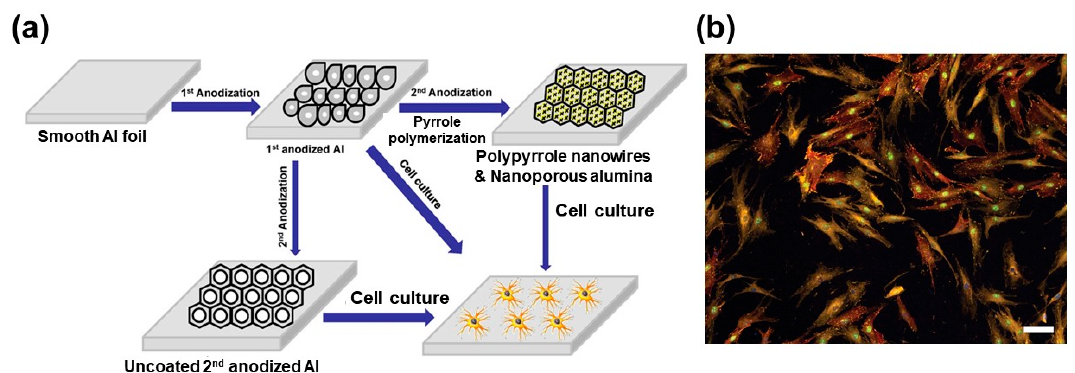
Figure 2. ( a ) Schematic diagram represented the fabrication of different cell culture substrates and the cell immobilization process. Reproduced with permission [37]. Copyright 2010 Elsevier. ( b ) Human fibroblasts after two days in culture on PPyThon film on gold. Green stains Ki67 (proliferation marker), yellow stains vinculin (focal adhesion marker), red stains actin (cytoskeleton). Nuclei counterstained with DAPI (blue). The scale bar is 100 µm. Reproduced with permission [38]. Copyright 2013 Elsevier.